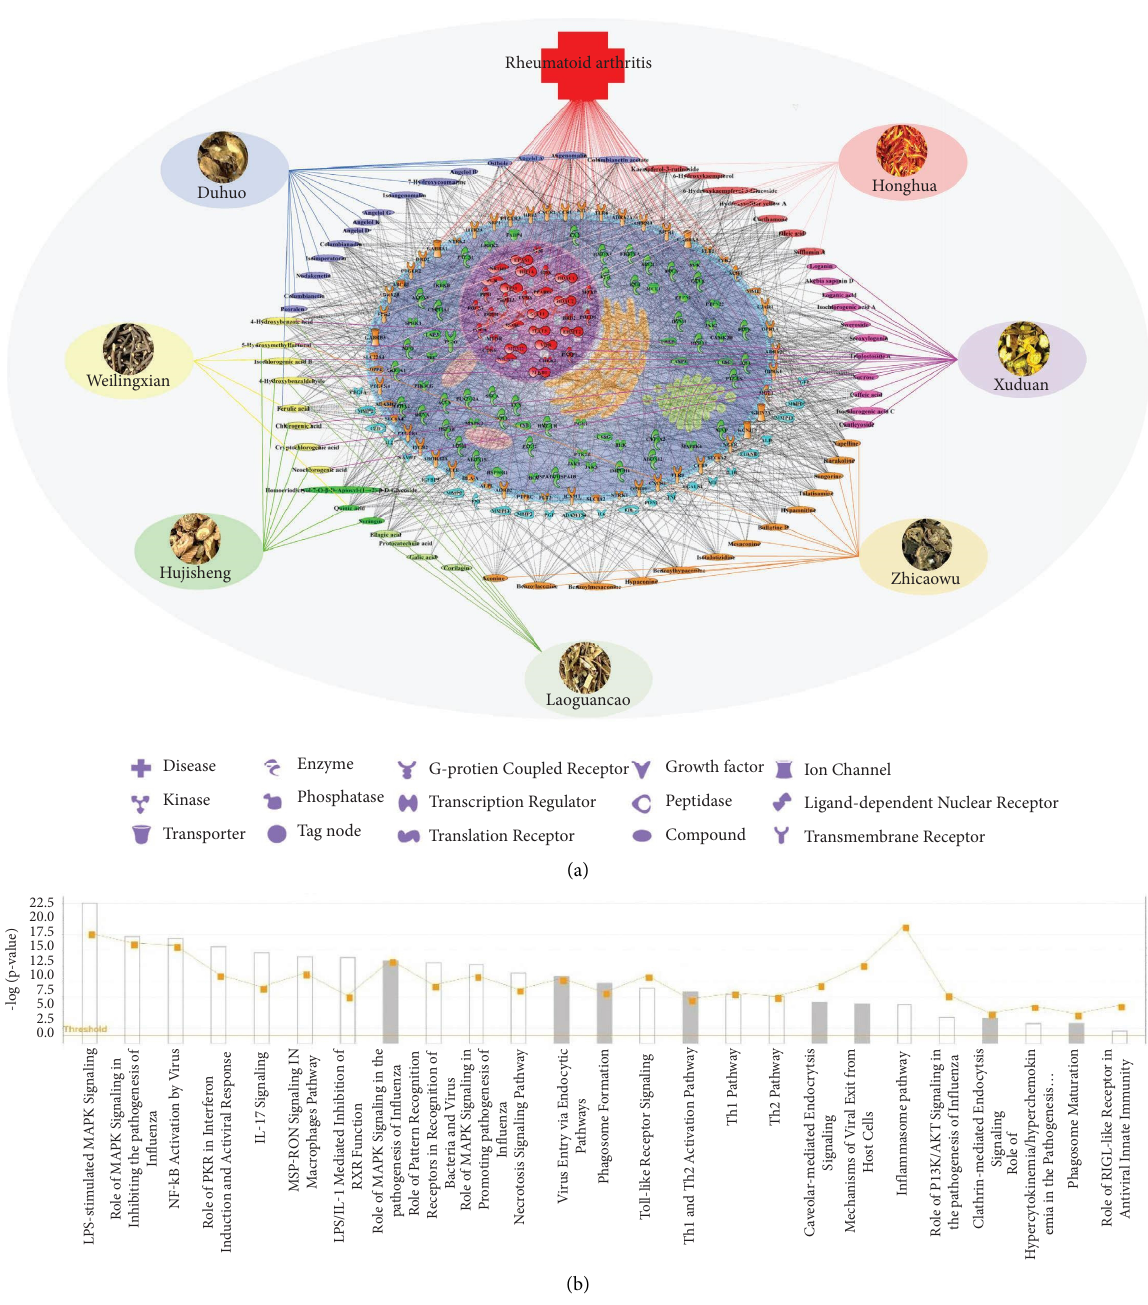
Figure 3: (a) Te network model of “QZC-components-targets-RA” and (b) canonical pathway analysis for pathogen-infuenced signaling of the predicted